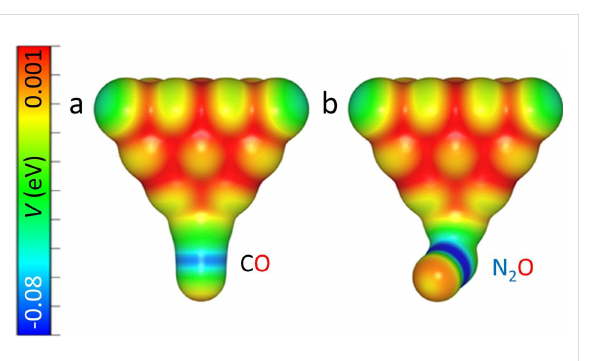
Figure 3: Comparison of the calculated electrostatic potential projec- tions of the CO (a) and N 2 O (b) tips obtained through DFT calcula-